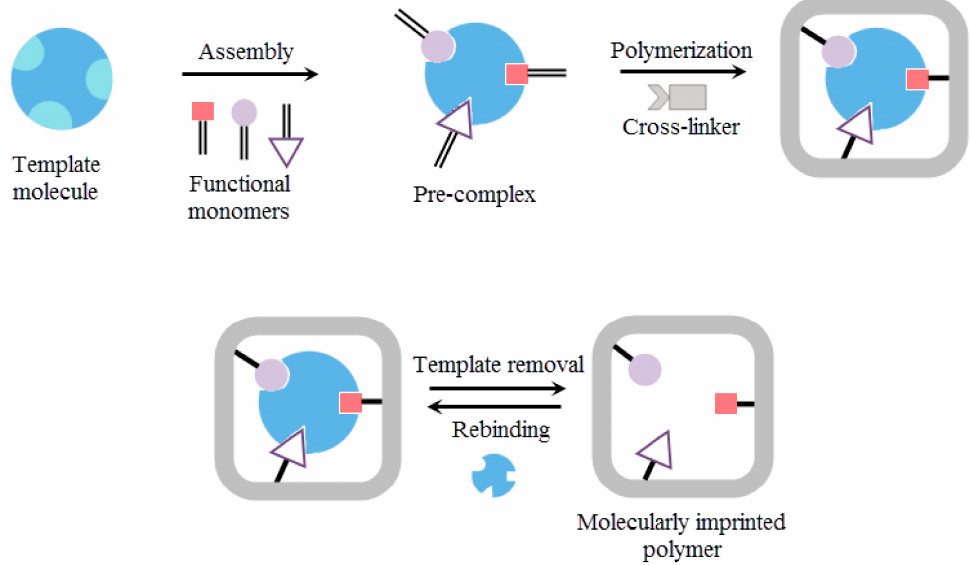
Figure 2. Schematic representation of generic synthesis and rebinding of molecularly imprinted polymers. Figure reproduced with permission from ref. [40].